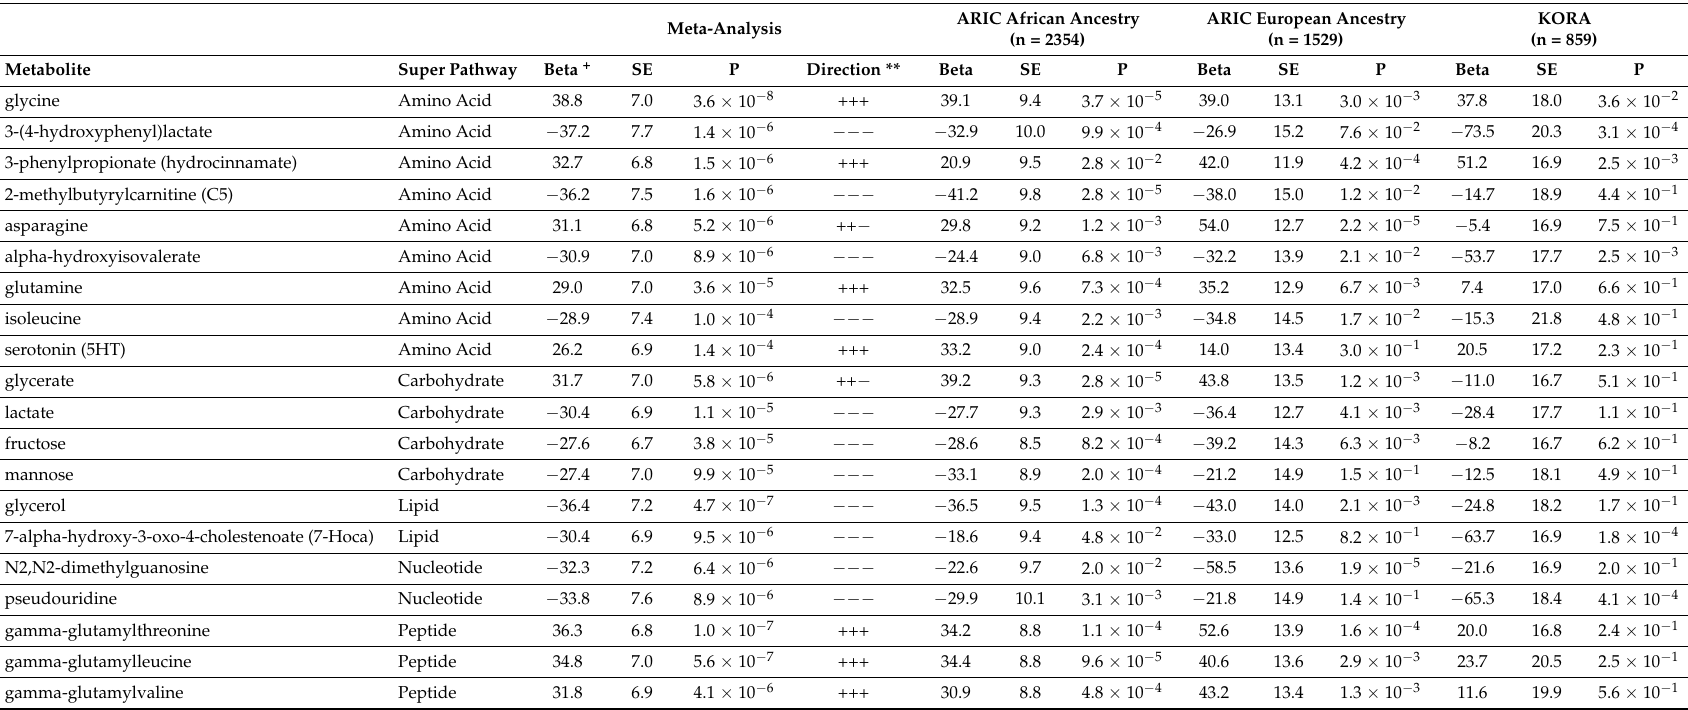
* Top 20 metabolites, based on meta-analysis p value, measured in all three populations are shown in this table; a total of 30 met Bonferroni correction. All 95 metabolites associated with FEV1 at FDR < 0.05 are shown in Supplementary Table S1. + Regression coefficient: mL difference in FEV1 per SD change of the metabolite levels. ** Direction of effect: the first, second and third +, or − refers to the direction of effect in ARIC African ancestry, ARIC European ancestry and